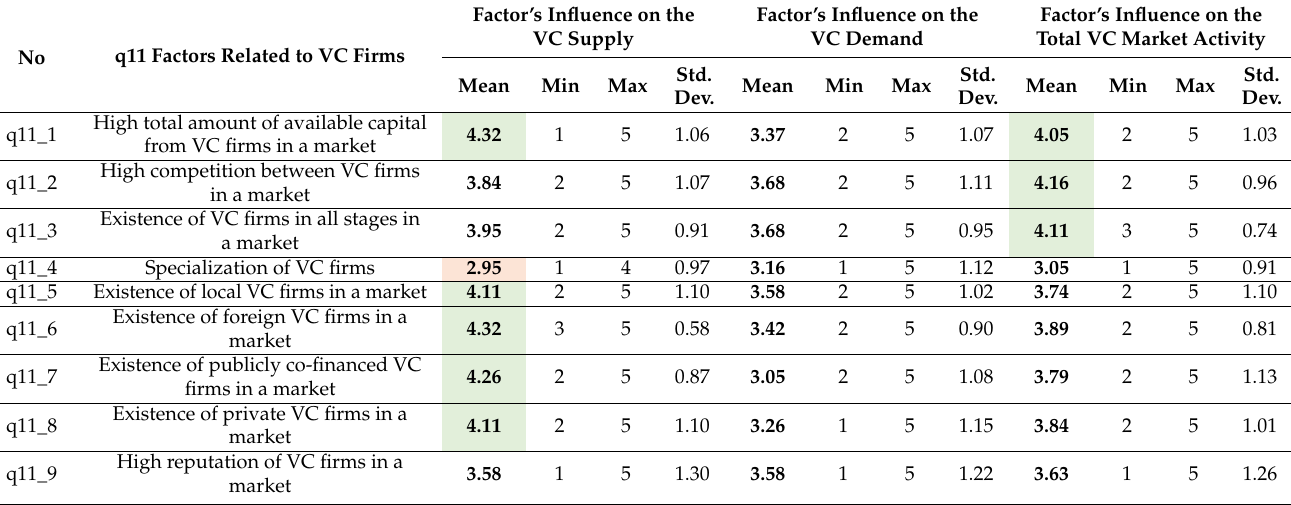
Figure 3. Values of the factors belonging to the metacategory “VC market participants”. The analysis shows that the characteristics of the VC firms have larger influence on the supply side and total market activity than demand. Nevertheless, the mean value for all dimensions (supply, demand, and total market activity) is high, and the bottom line of the first quartile for all dimensions is above the middle rating. Further, the results of the study are explained on the subfactors level. Each factor consists of several subfactors, the weight of which experts were asked to rate. From the factors’ group, which are related to “VC firms”, several factors have a strong influence on the market (Table 8)—highlighted in green. Three factors have a below-moderate influence (highlighted in red), still only on one side of the market. Table 8. The subfactors related to VC firms’